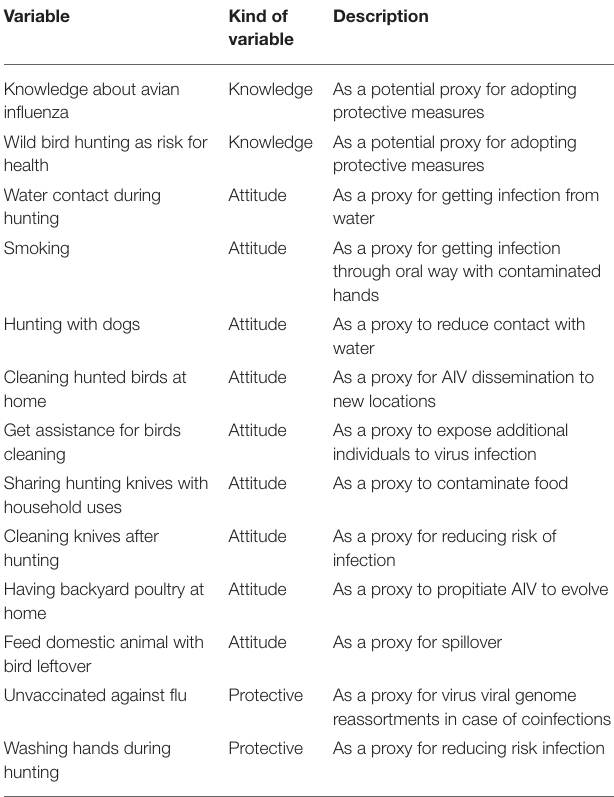
TABLE 1 | Variables related with knowledge, perception and risk attitudes used for